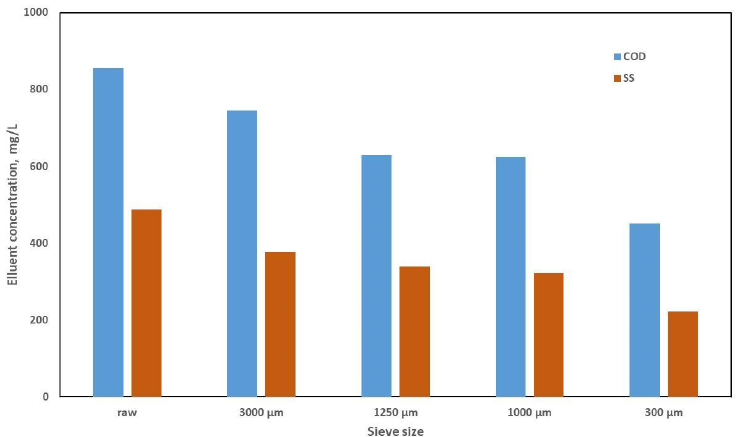
Figure 8. COD and suspended solid content in the aqueous samples collected downstream of sieves with certain opening sizes.